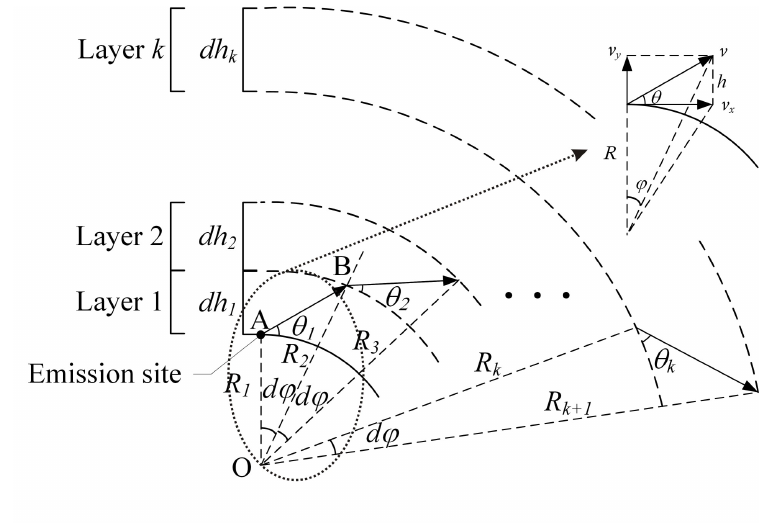
Figure 3. Schematic diagram of the layered troposphere and propagation path of the radio wave. Combining (10) and (11) provides the